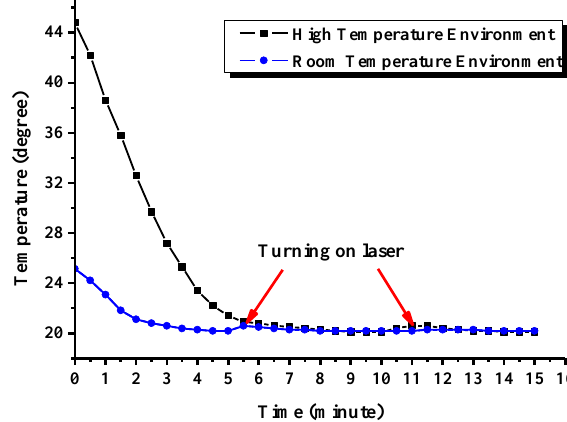
Figure 11. Temperature variation of the pump laser.